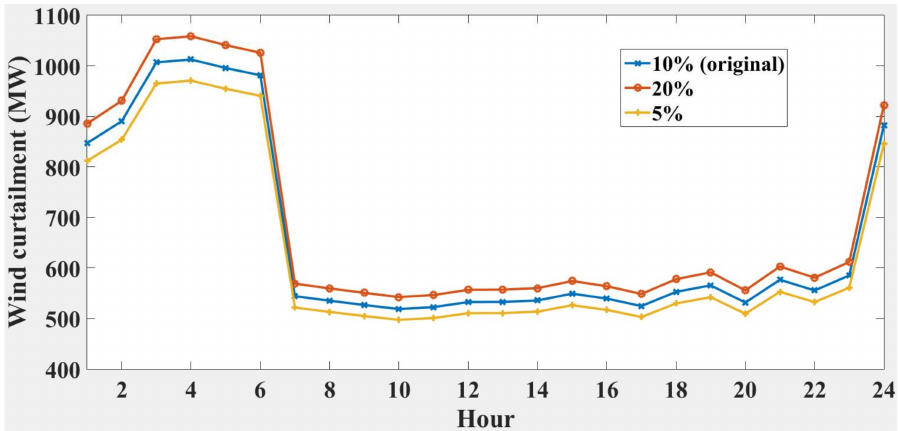
Figure 6. Wind energy curtailment level at various DTR system investment